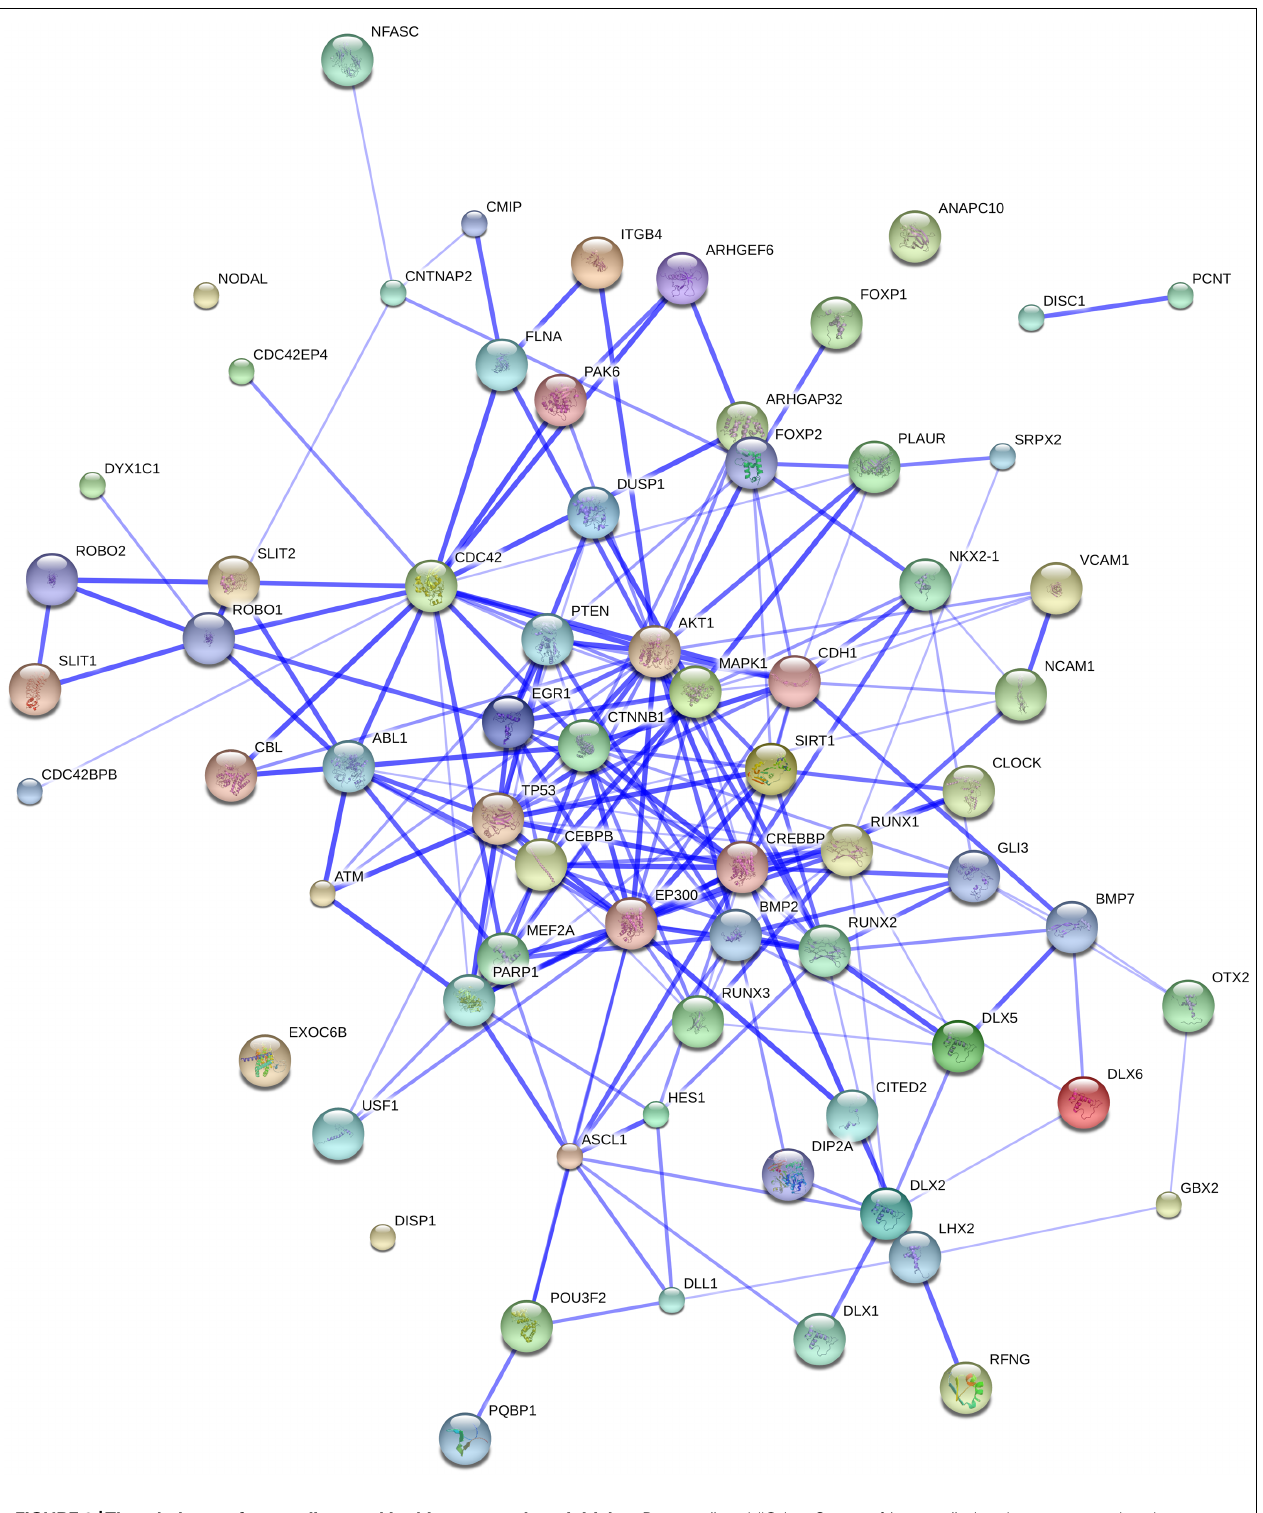
FIGURE 3 |The whole set of genes discussed in this paper and our initial gene set related to globularity. The network was generated by String 9.1 with the proteins discussed in Sections “The ROBO/SLIT Suite,” “ FOXP2 and